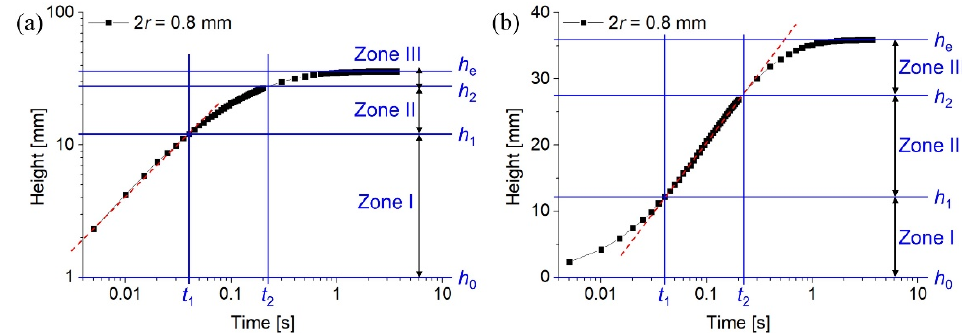
Figure 5. Variation of height ( h ) versus time ( t ) for the DW rise in capillary tube at test case of 2 r = 0.8. ( a ) h (log 10 mm) versus t (log 10 s) and ( b ) h (mm) versus t (log 10 s).